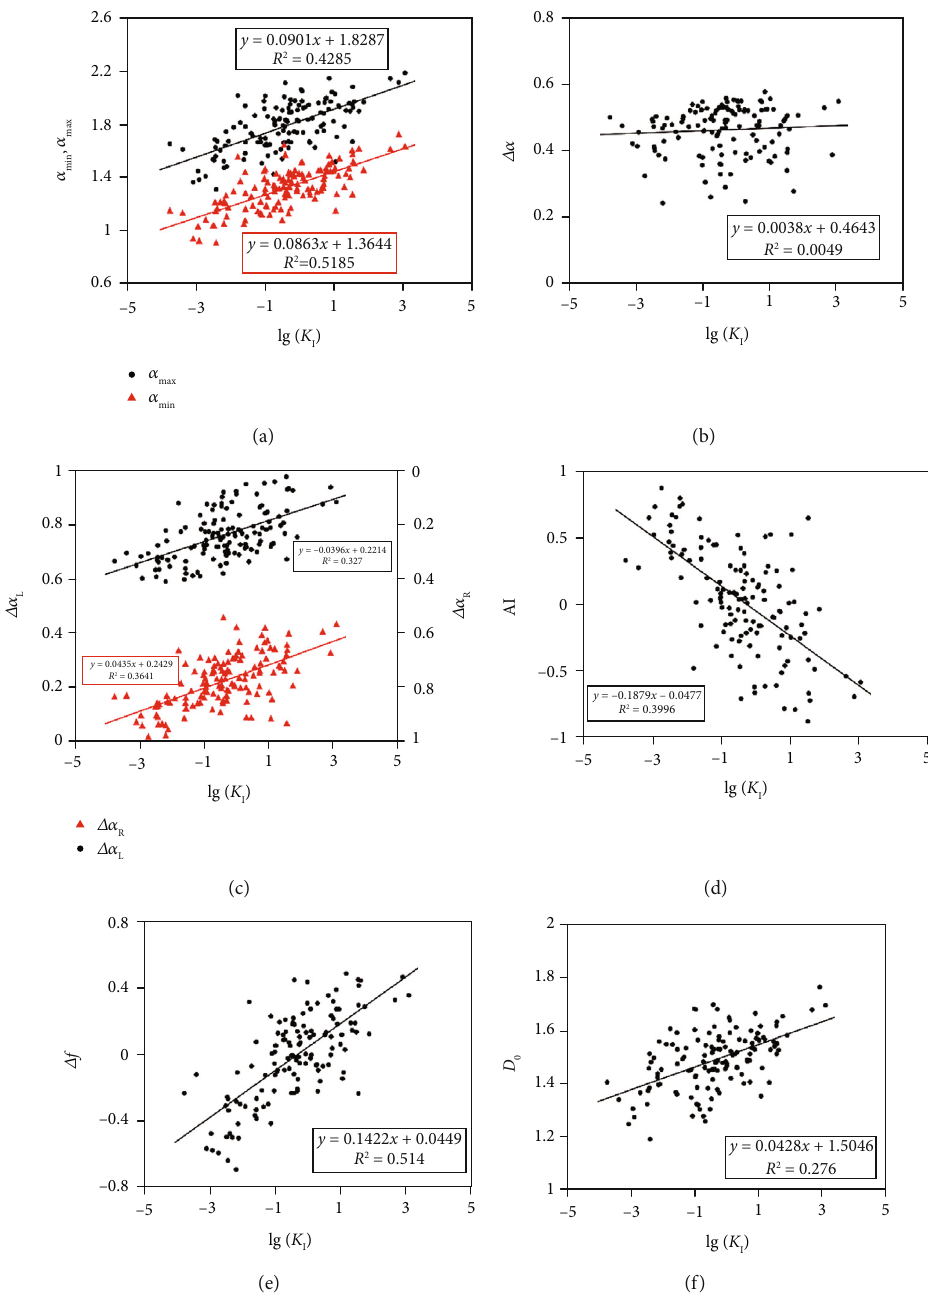
α min and max Δ f and